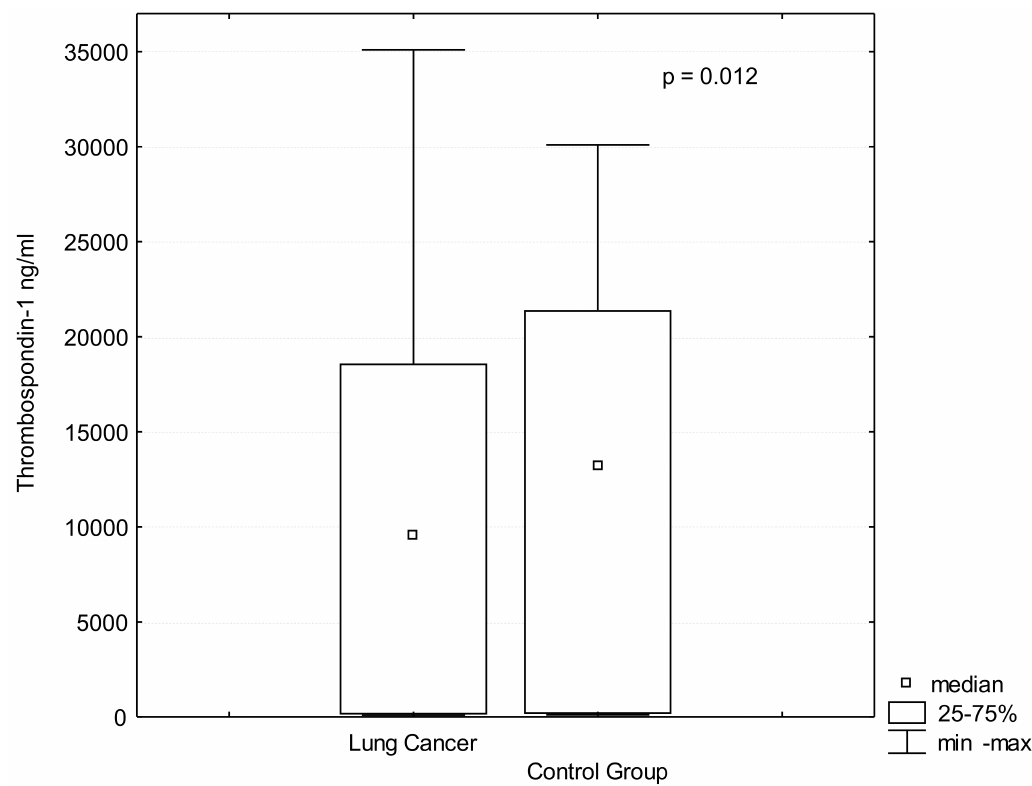
Figure 1. TSP-1 (Thrombospondin-1) serum levels in lung cancer and control group.